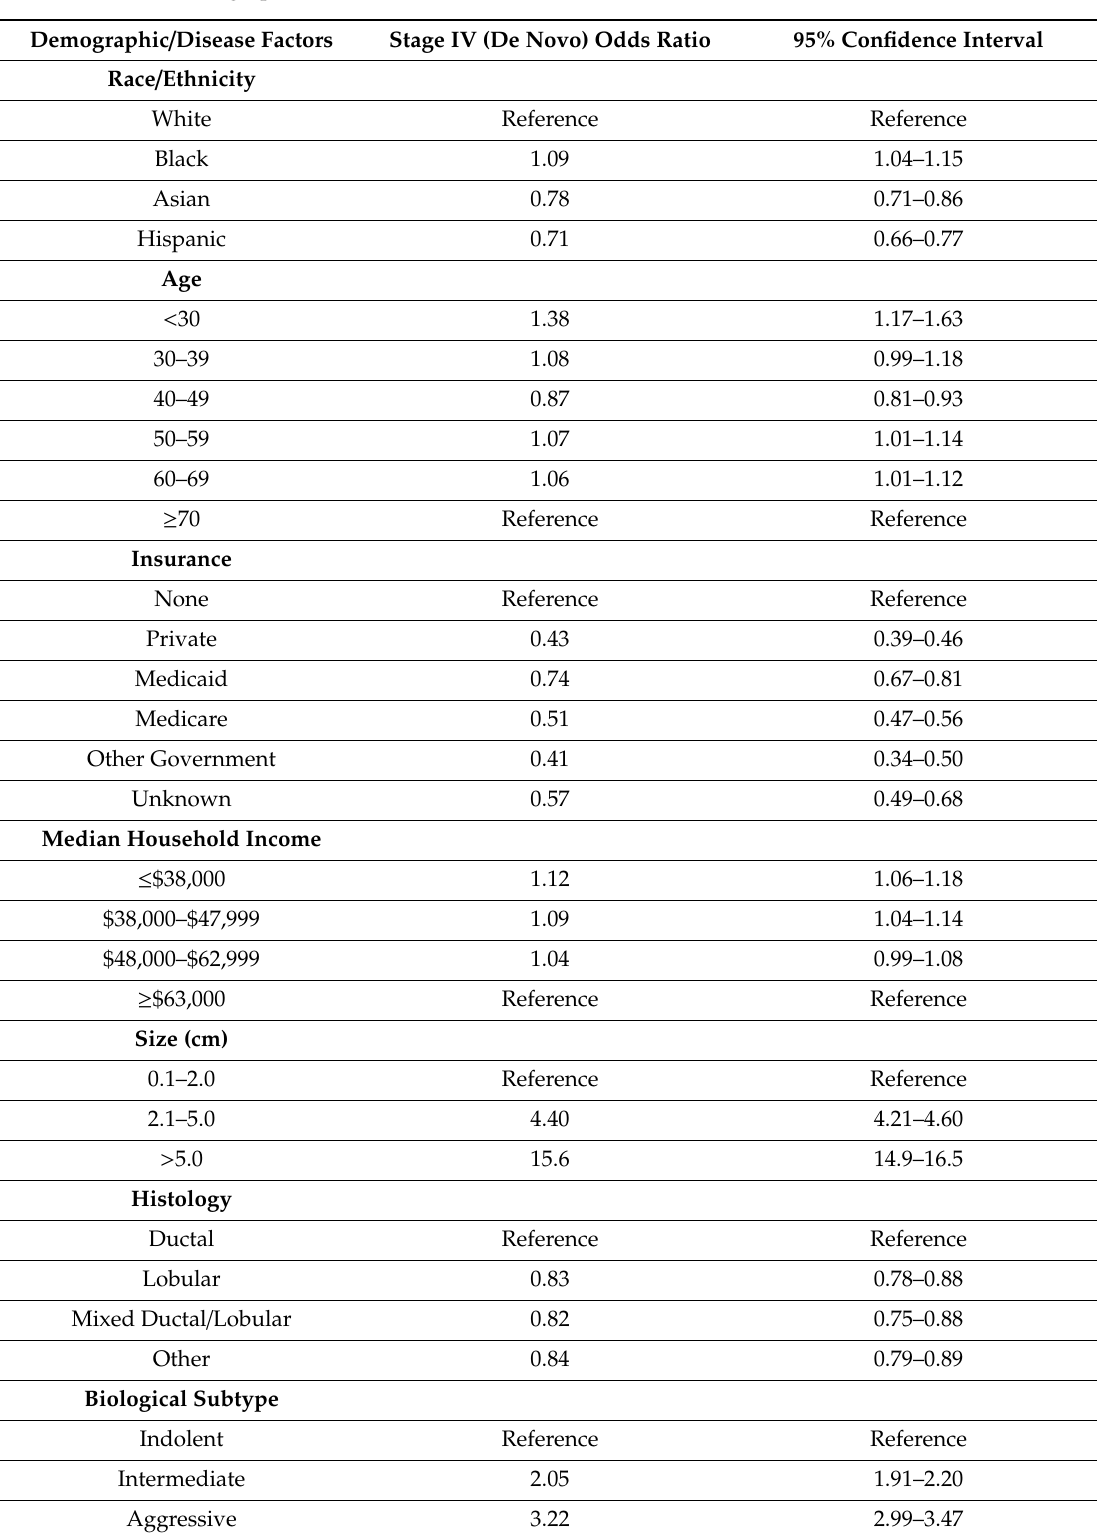
Table 3. Multivariable logistic regression demonstrating the strength of association between Stage IV disease and demographic and disease